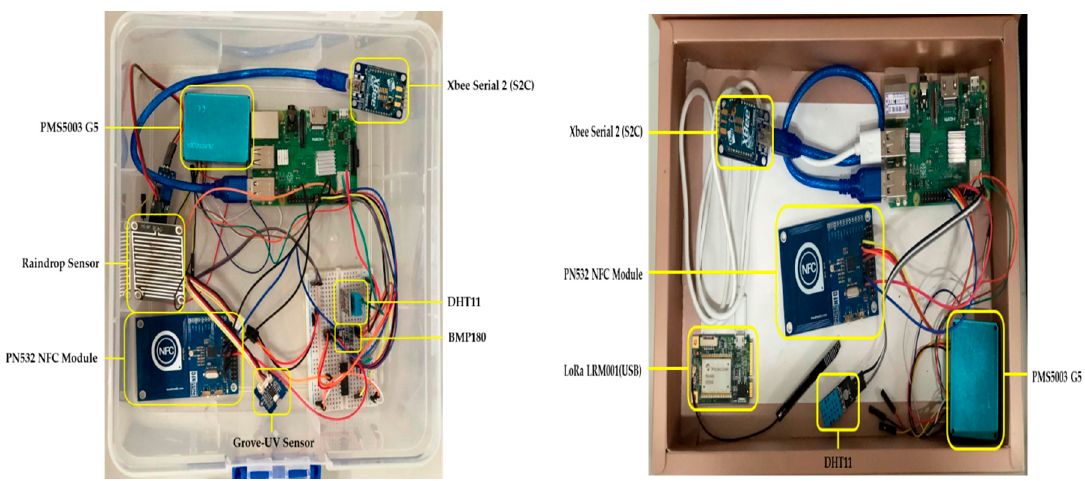
Figure 7. The bus experimental module (left); the bus station experimental module (right).